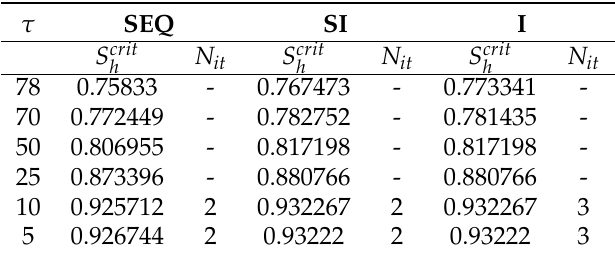
Table 3. Robustness of nonlinear solvers depending on the variant and the time step for the simulations of the base case between T = 25 K and T = 50 K . The robustness is assessed by checking which solver variant is more prone or more robust to failing in the difficult modeling circumstances close to unphysical. We report the critical value S crit obtained before the solver fails, and on the h number N it of iterations. When N it is denoted by “-”, this means the solver did not complete. For SEQ model, N it denotes the number of flash iterations. For the SI and I models, N it denotes the number of global Newton iterations. τ